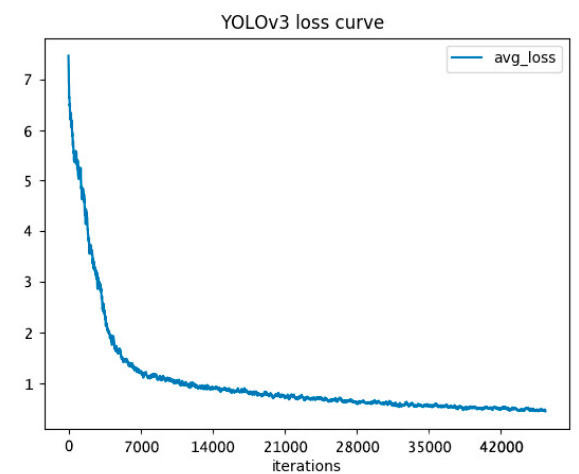
Figure 11. Loss curve of YOLOv3. We set the iterations to 50,000. Other parameters are described in Section 3.1. The training was stopped when achieving the max iterations.